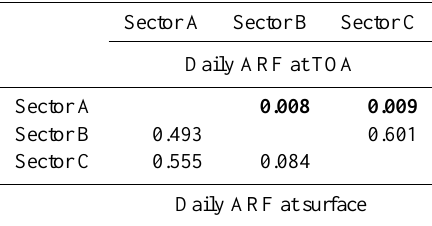
Table 3. The p values of the Kolmogorov-Smirnov statistical test applied to ARF at surface and TOA data for each pair of origin sectors. The p values above the diagonal, for each pair of data, cor- respond to the daily ARF at TOA, while the values below the di- agonal correspond to the daily ARF at surface. Values of p < 0 . 05 indicate statistical significant differences between the means at the 95% confidence